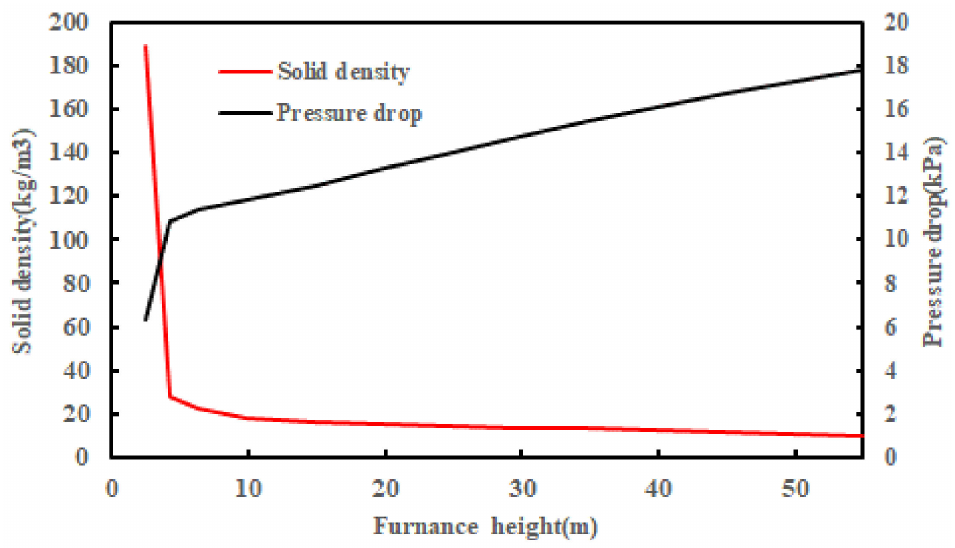
Figure 10. The solid density distribution and pressure drop in the